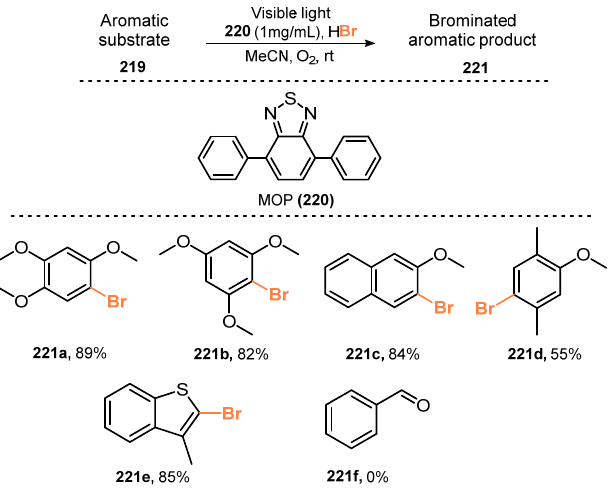
Scheme 59. Photocatalytic-selective bromination of aromatic compounds using